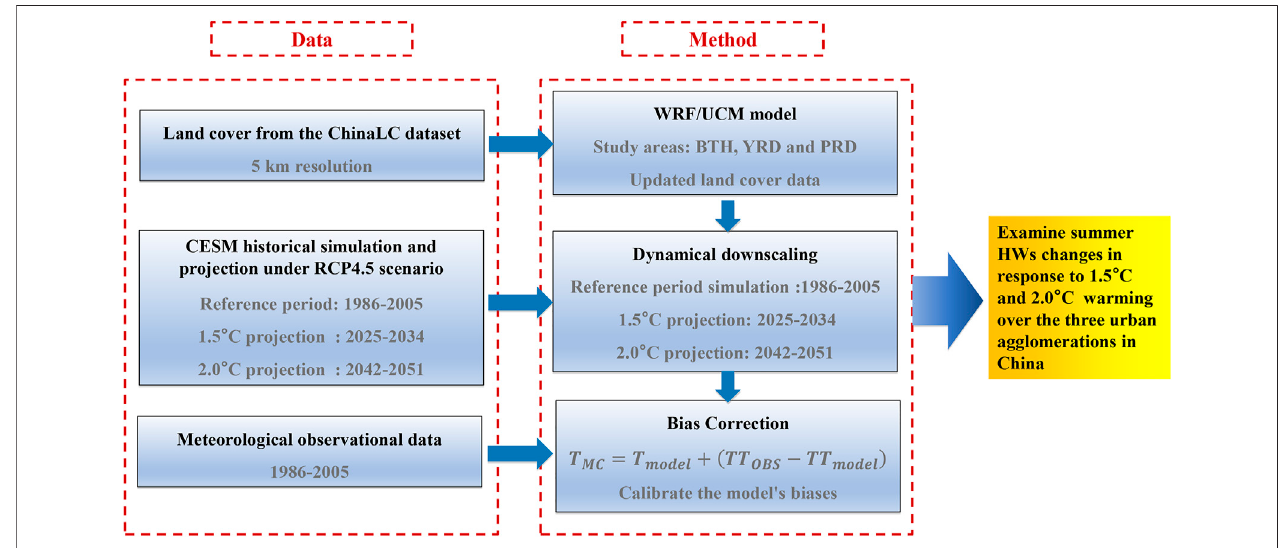
FIGURE 2 | Flow chart for the examination of future changes of summer heat waves over the three urban agglomerations.